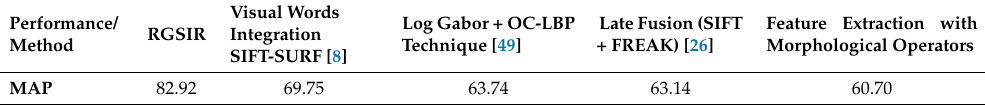
Table 5. Comparison of the mean average precision using OT-Scene image